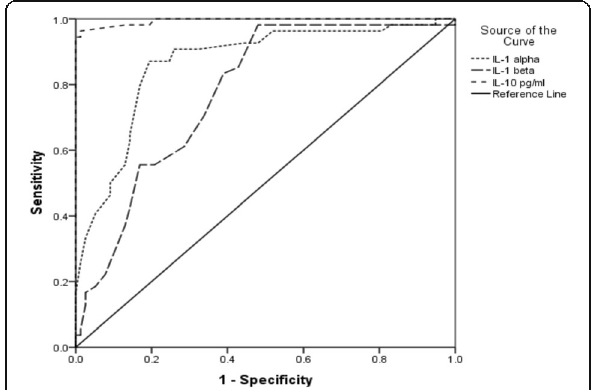
Fig. 2 ROC curve of inflammatory cytokines (IL1- α , IL1- β , and